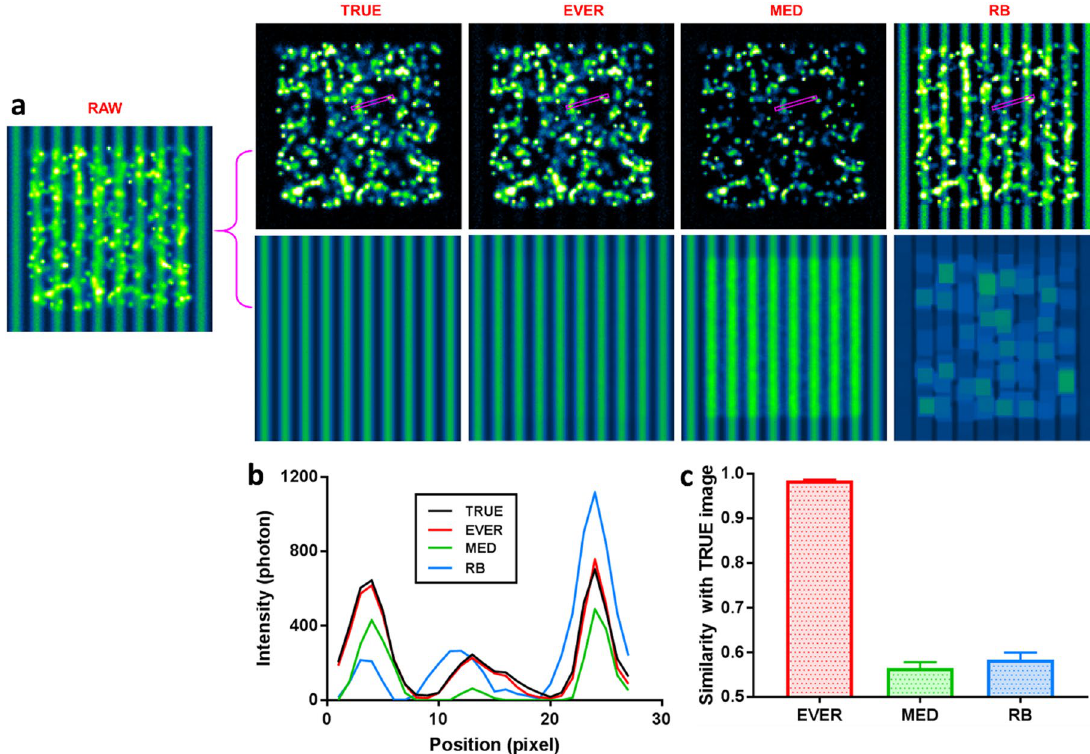
Figure 2. ( a ) A simulated raw image where the emitters are mixed with heterogeneous background, and the emitter and background images are recovered by ground-truth (TRUE), extreme value-based emitter recovery (EVER), temporal median filter (MED) and spatial rolling ball filter (RB). ( b ) The intensity profile of the region in the magenta rectangular box of ( a ). ( c ) Image similarity between the recovered emitter images using EVER, MED and RB and the TRUE